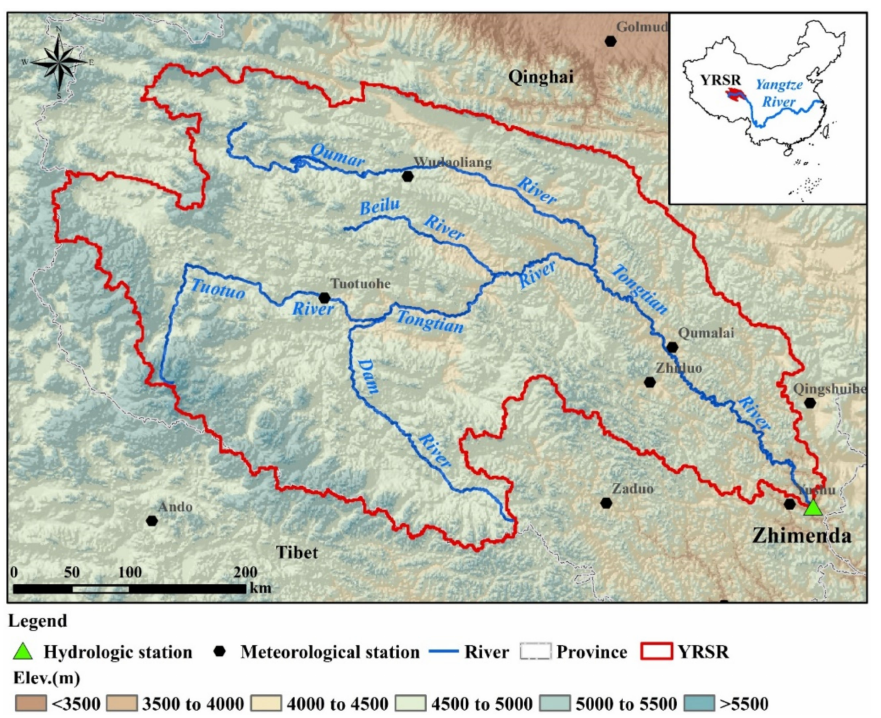
Figure 1. Location of the Yangtze River Source Region (YRSR),